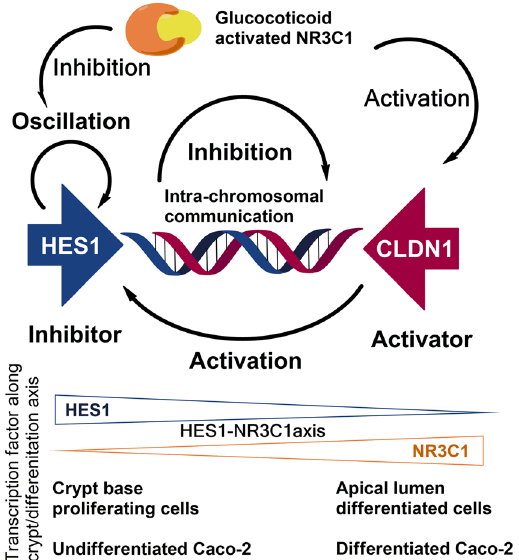
Figure 8. Proposed model for regulatory circuits of HES1-CLDN1 along colon crypt axis. Regulatory circuits of HES1-CLDN1 pathways are similar to that of colon & neuroectoderm patterning Notch–Delta inhibitor- activator pair. Potential chromosomal intra-communication between HES1 and CLDN1 coded close and oppositely on human chromosome 3 made them candidates to test Alan Turing’s 1952 gene morphogen hypothesis. Glucocorticoid activated NR3C1 inhibits HES1 promoter and activate CLDN1 promoter via GRE elements. Chronically elevated glucocorticoid levels may impair colon epithelium barrier function via HES1- NR3C1 axis. This model is consistent with an activator/inhibitor gene morphogen pair, originally proposed by Alan Turing 23, 26 (refer to Discussion Section for additional